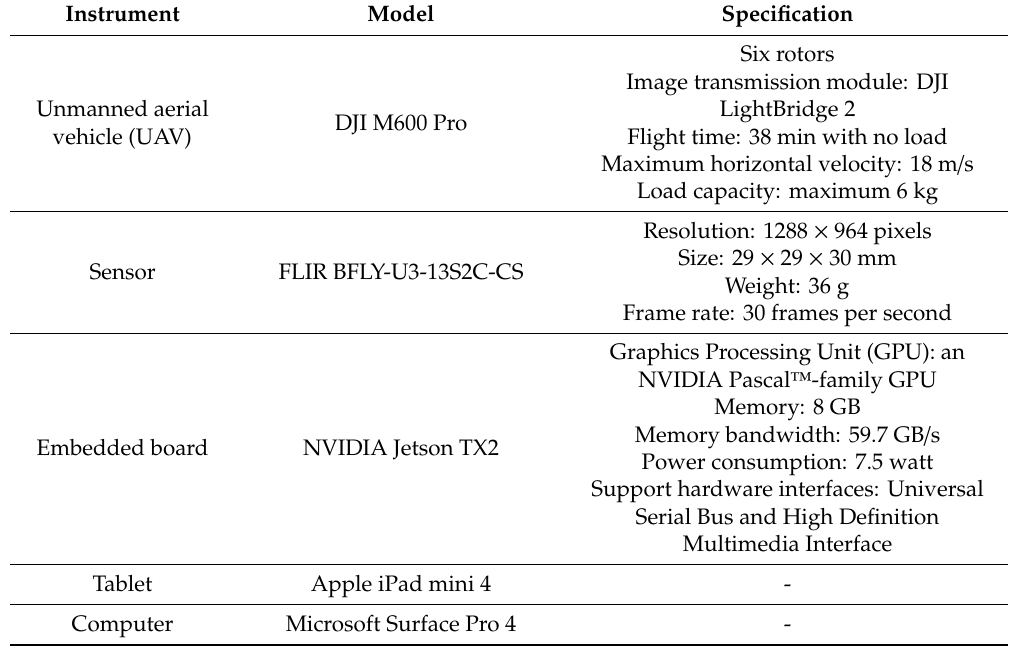
Table 1. Instruments used in this study for excavator detection.